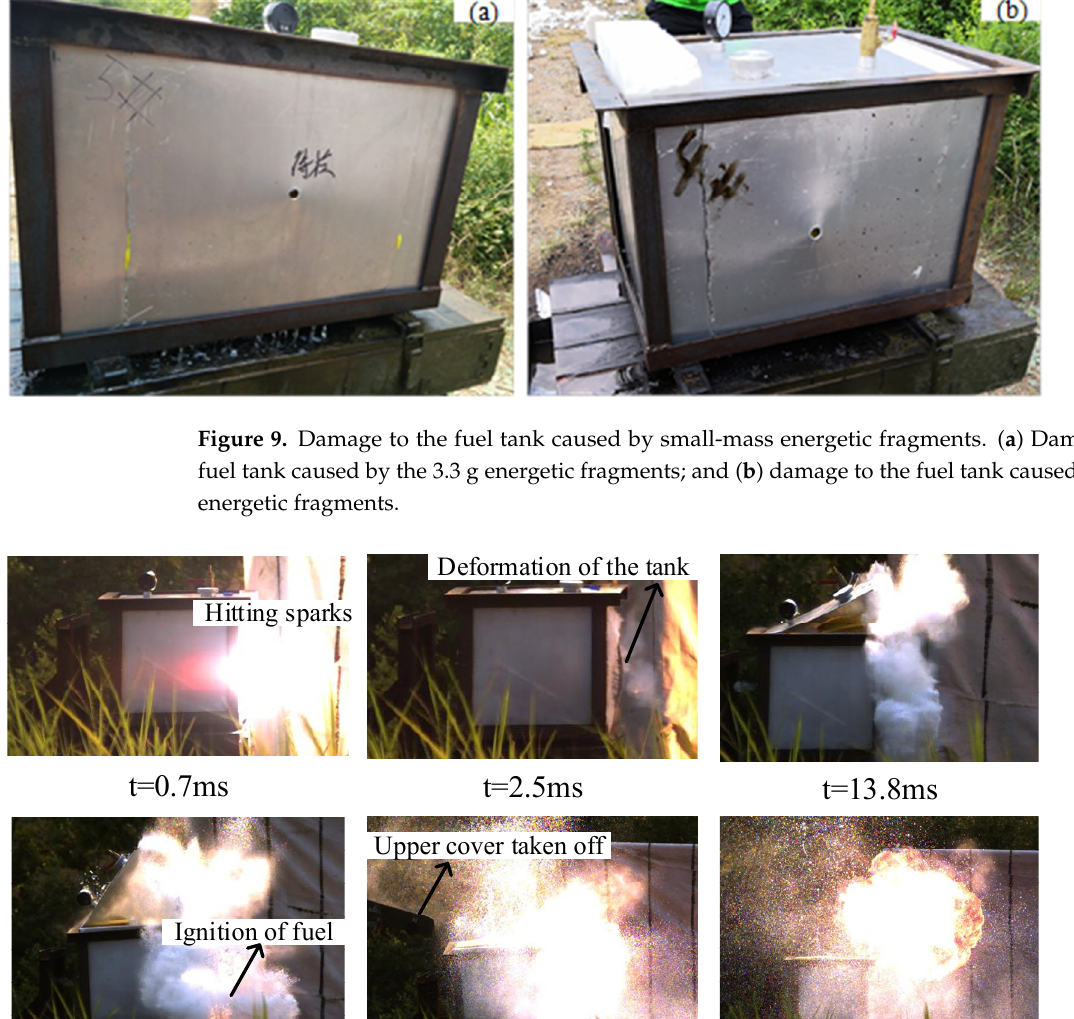
(b) Figure 8. Damage and destruction of the fuel tank caused by the 35 g steel fragments (v = 2298 m/s).